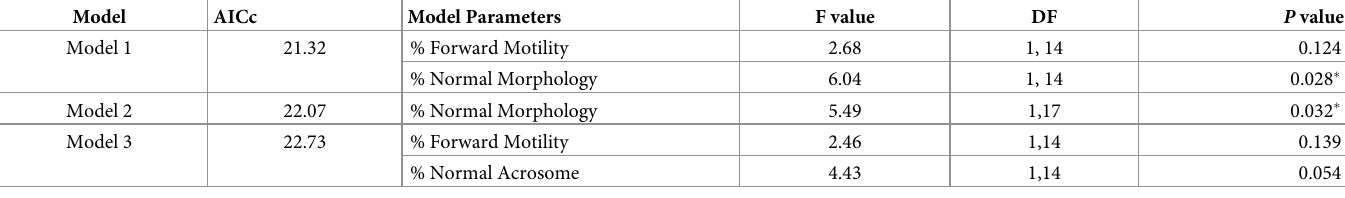
Table 2. Summary table of top Anova models based on lowest AICc scores for fertilization rate in captive breeding Louisiana pinesnakes (n = 20).